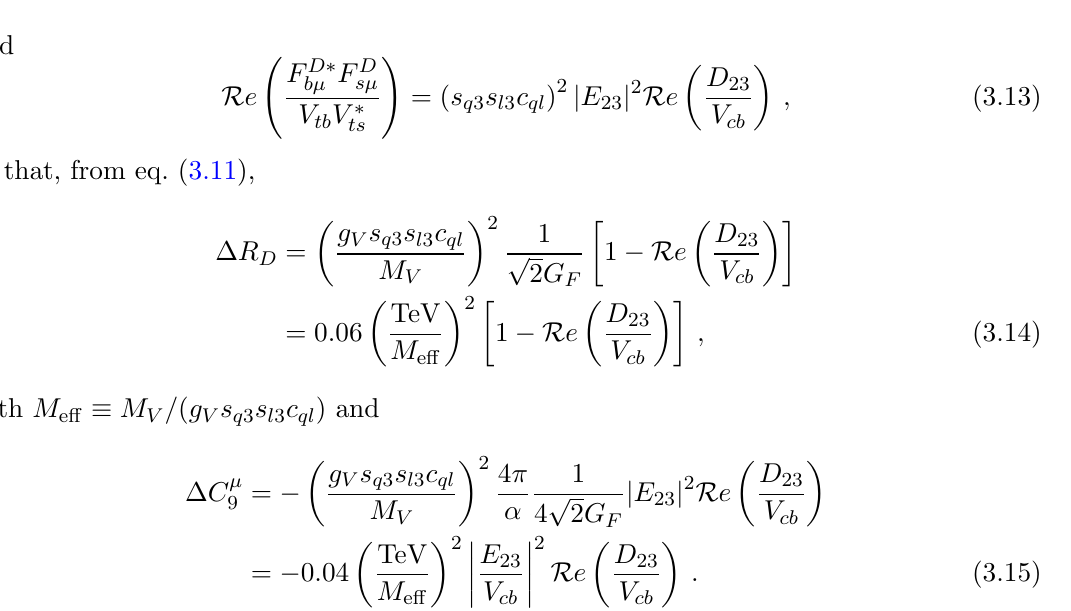
respectively, and x }